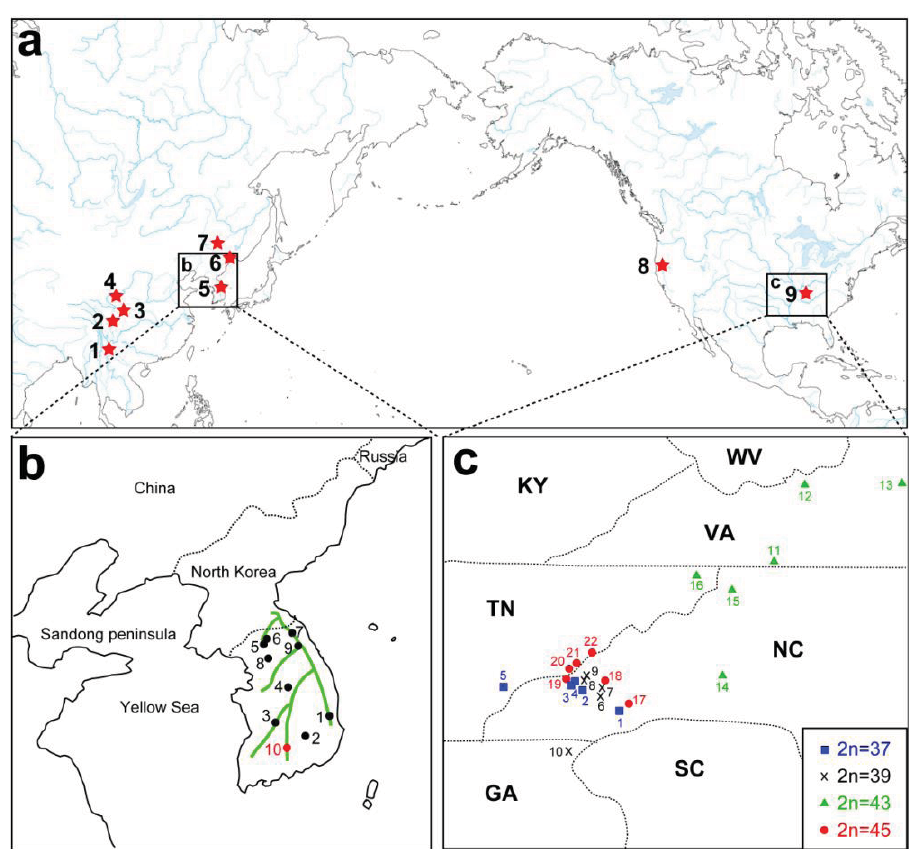
( c ) Distribution of male karyotypes of the C. punctulatus species complex in the Everaerts et al. [11]). Location numbers correspond to sites shown in Figure